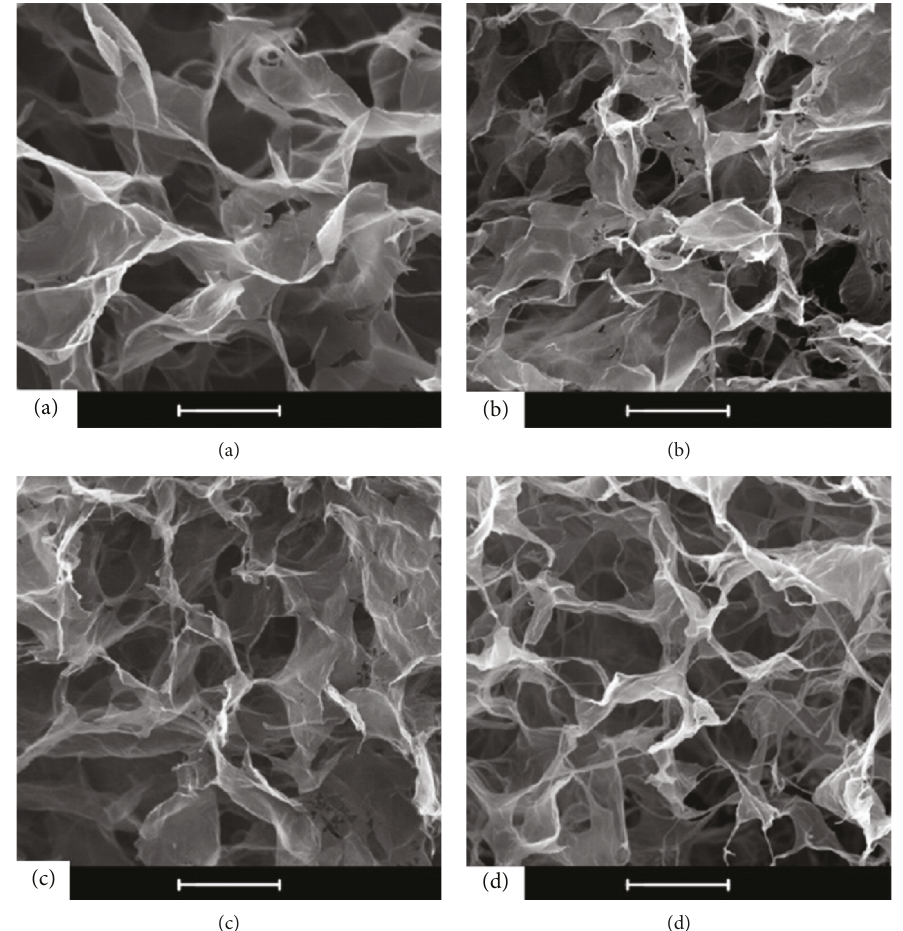
Figure 4: SEM images of lyophilized GO solution and three typical GO hydrogels: (a) GO solution, (b) GO/PVP hydrogel with 1 mgmL − 1 PVP, (c) GO/PDDA hydrogel with 0.1mgmL − 1 PDDA, and (d) GO/Ca 2+ hydrogel with 9mM Ca 2+ . C μ m [111].